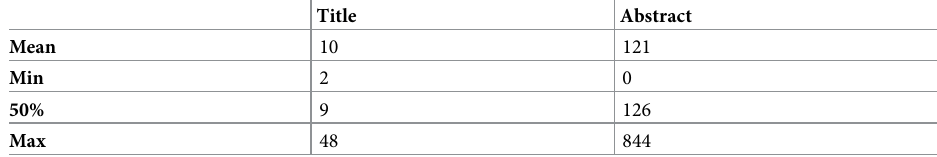
Table 1. Word count summary for researcher publications.